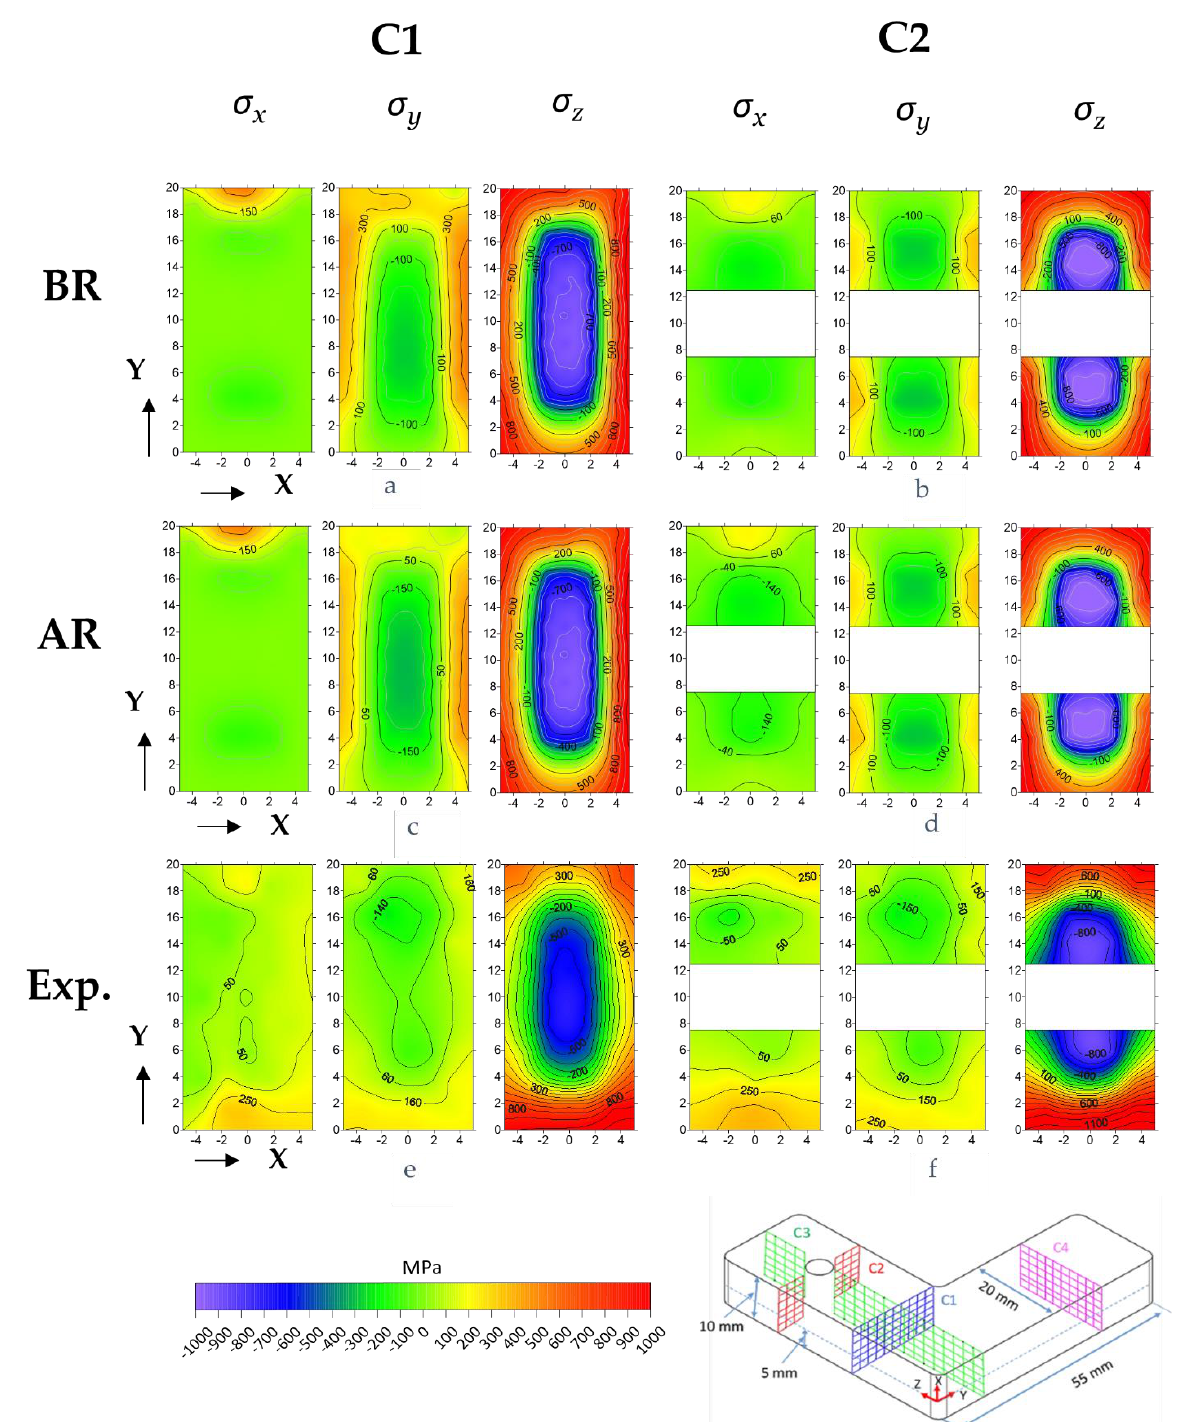
Figure 13. Stress distribution for VB at cross-section C1 and C2: ( a , b )-Results from simulation before base plate removal, ( c , d )-Results from simulation after removal of the base plate, ( e , f )-Experimental results reprinted from ref. [30].